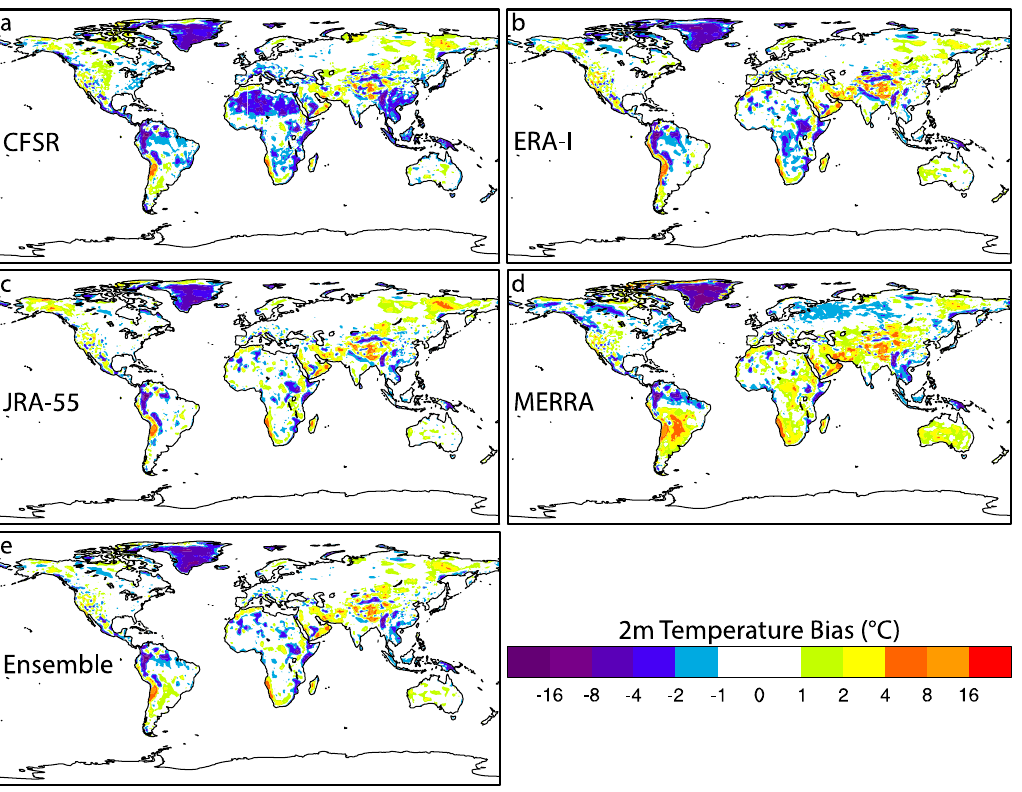
Figure 1. ( a – d ) Gridded differences in 2-m air temperature for each reanalysis model subtract Global Historical Climatology Network (GHCN) over the 1981–2010 period. Panel ( e ) shows the same but for the ensemble mean.